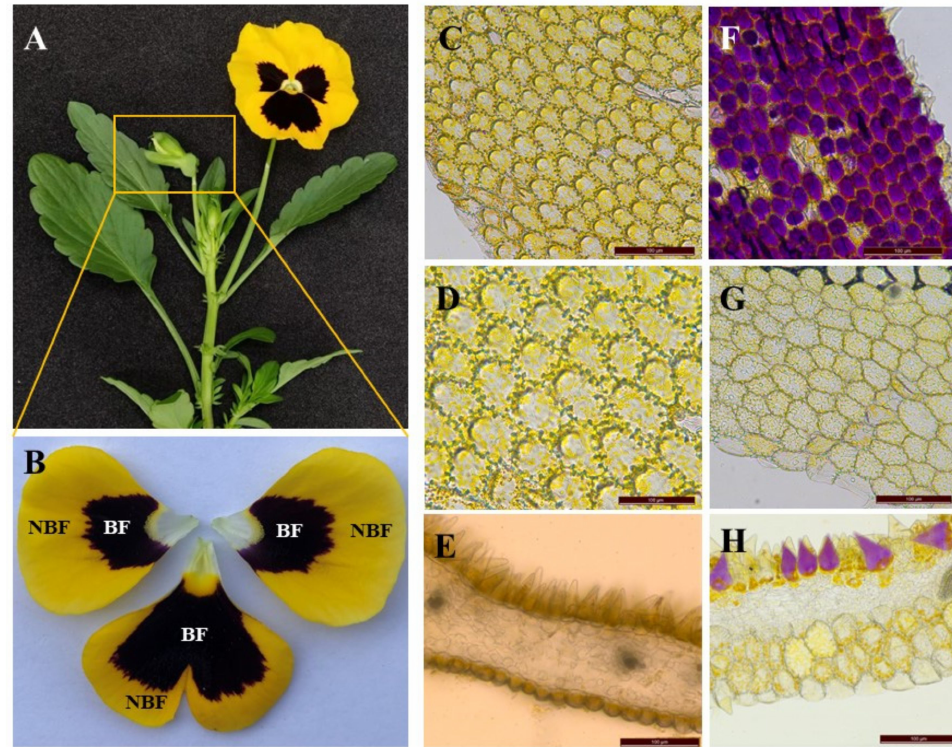
Figure 1. Cellular features of pansy. ( A ) Whole plant of pansy; ( B ) lower three petals of pansy at stage 5, NBF: non-blotched part of petals, BF: blotched part of petals. NBF and BF petals were labeled, respectively; ( C , D , E ) phenotype of NBF, from top to bottom: adaxial epidermal cells, abaxial epidermal cells, cross-section; ( F , G , H ) phenotype of BF, from top to bottom: adaxial epidermal cells, abaxial epidermal cells, cross-section. Bars, 100